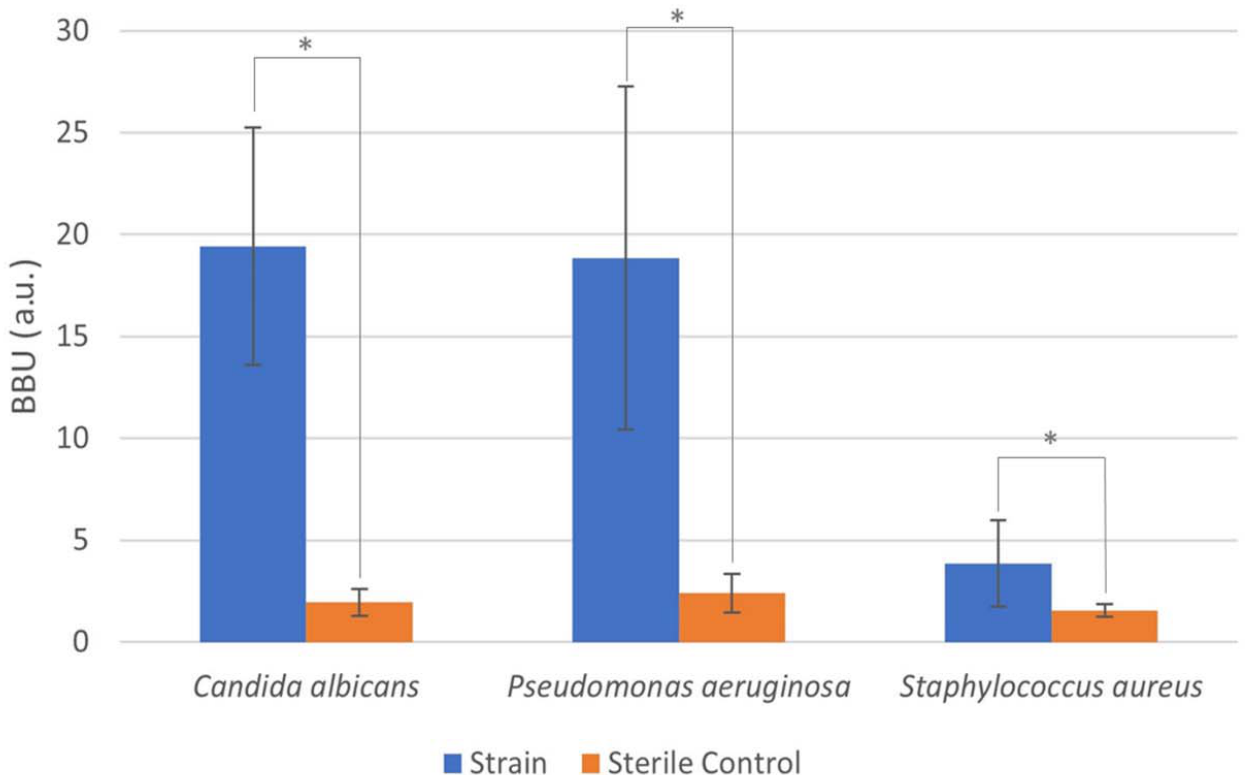
Figure 1. Biofilm-forming ability of Candida albicans , Pseudomonas aeruginosa , and Staphylococcus aureus . Right : Sterile control. Left : Strain. * p < 0.05.